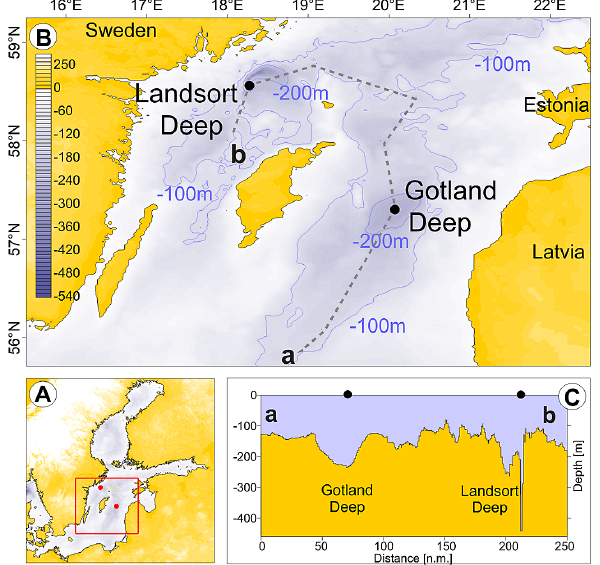
Fig. 1. ( A) Sampling sites in the central Baltic Sea (red dots). (B) Bathymetric map of the central Baltic Sea with the Gotland Deep in the eastern Gotland Basin and the Landsort Deep in the western Gotland Basin. (C) Cross section from the eastern (a) to the western Gotland Basin